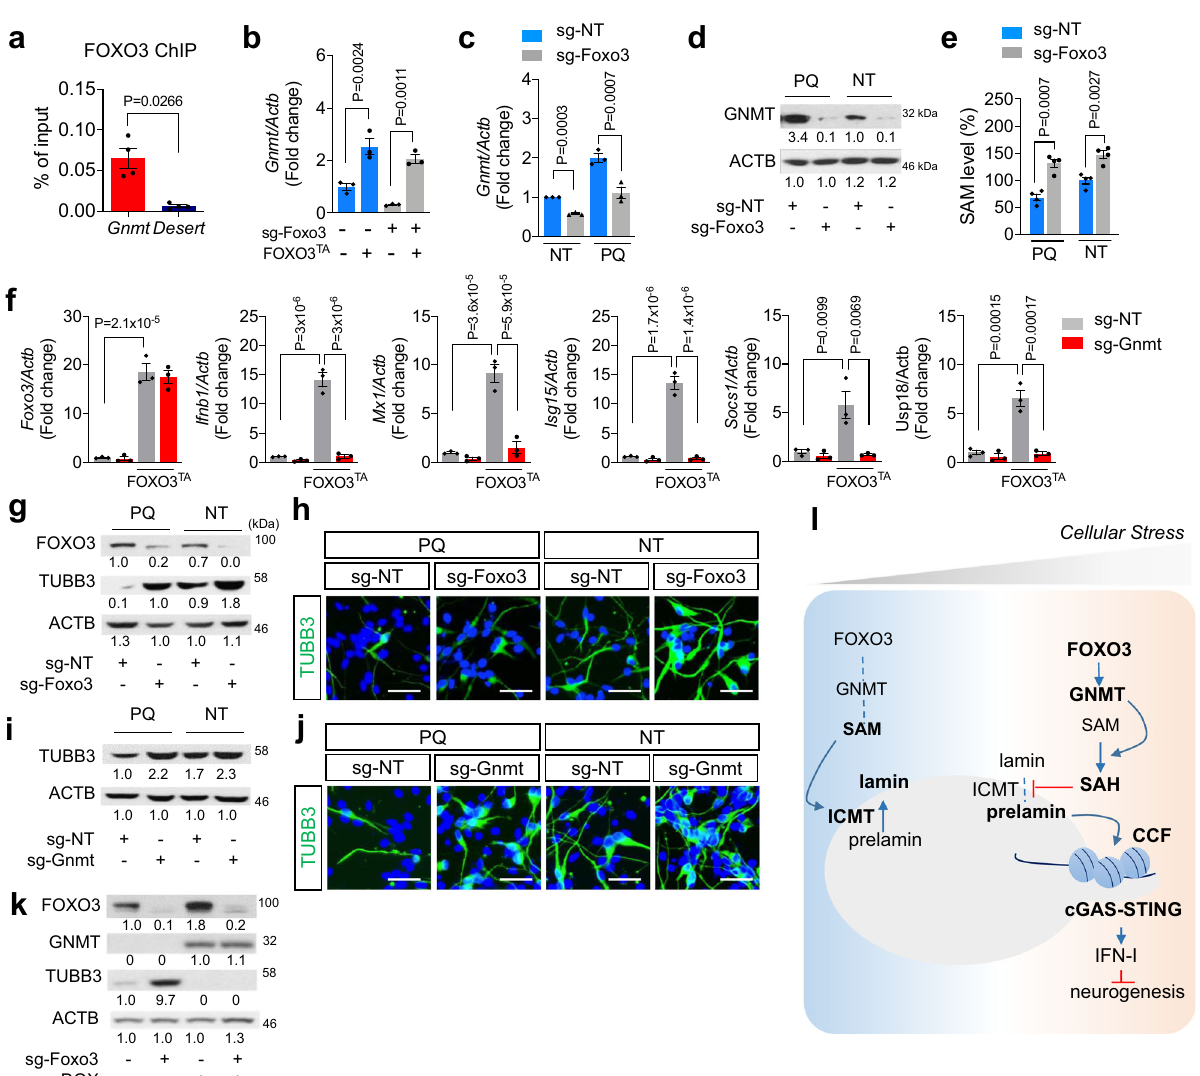
Fig. 7 Redox stress impacts neurogenic potential of NSPCs through regulating SAM levels. a FOXO3 ChIP-qPCR analysis at Gnmt promoter in comparison to a gene desert region. Mean± s.e.m. of four independent experiments. qRT-PCR ( b , c ) and WB ( d ) results for GNMT expression in NSPCs treated with PQ for 48 h. Mean± s.e.m. of three independent experiments. e SAM levels in NSPCs expressing sg-NT or sg-Foxo3 treated for 48 h as indicated. Hundred percent of SAM = 50 µ M. Mean± s.e.m. of four independent experiments. f qRT-PCR results for Foxo3 and ISGs on either control adenovirus or FOXO3 TA adenovirus-infected NSPC. Mean ± s.e.m. of three independent experiments. Statistical signi fi cance was determined by two-sided unpaired t -test for a and by one-way ANOVA for b, c , e , and f . WB ( g , i , and k ) and IF ( h and j ) for TUBB3 expressions of each NSPC line on 3 day of differentiation. Scale bar = 40 µ m. Experiments for d , g , h , i , j , and k were repeated three times independently with similar results and representative images/blots are shown. k . Model for the mechanism how cellular stress elicits IFN-I response and inhibits neurogenic differentiation potential of neural stem